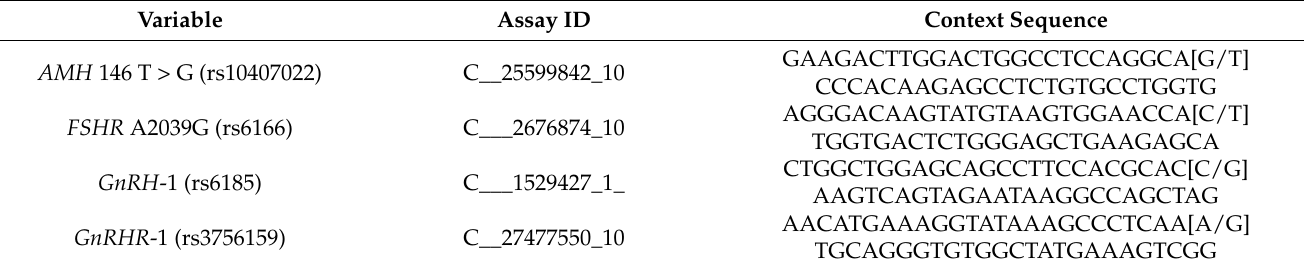
Table 1. The context sequence of four primers to detect AMH , FSHR , GnRH , and GnRHR SNPs in the study.